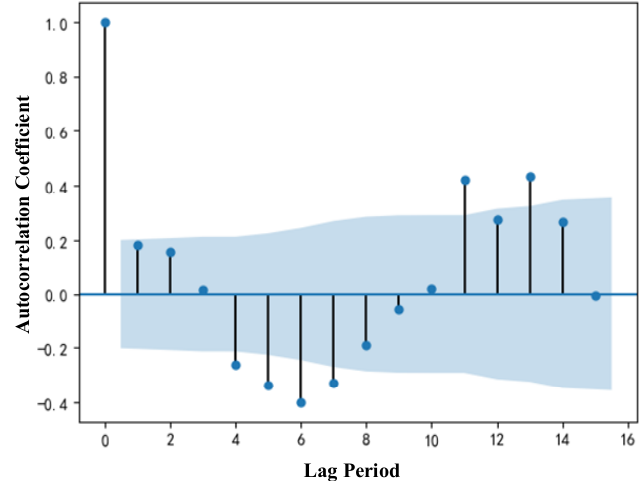
Figure 10. Offset azimuth ACF analysis.